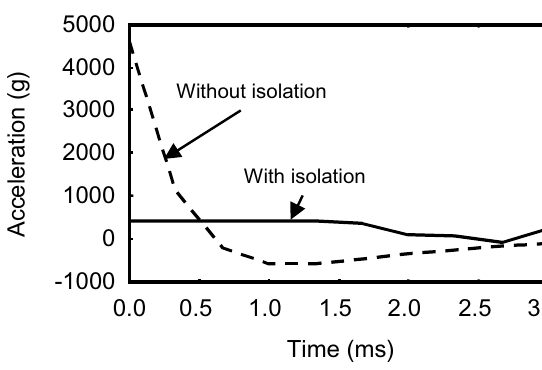
Fig. 9. Optimum force function.